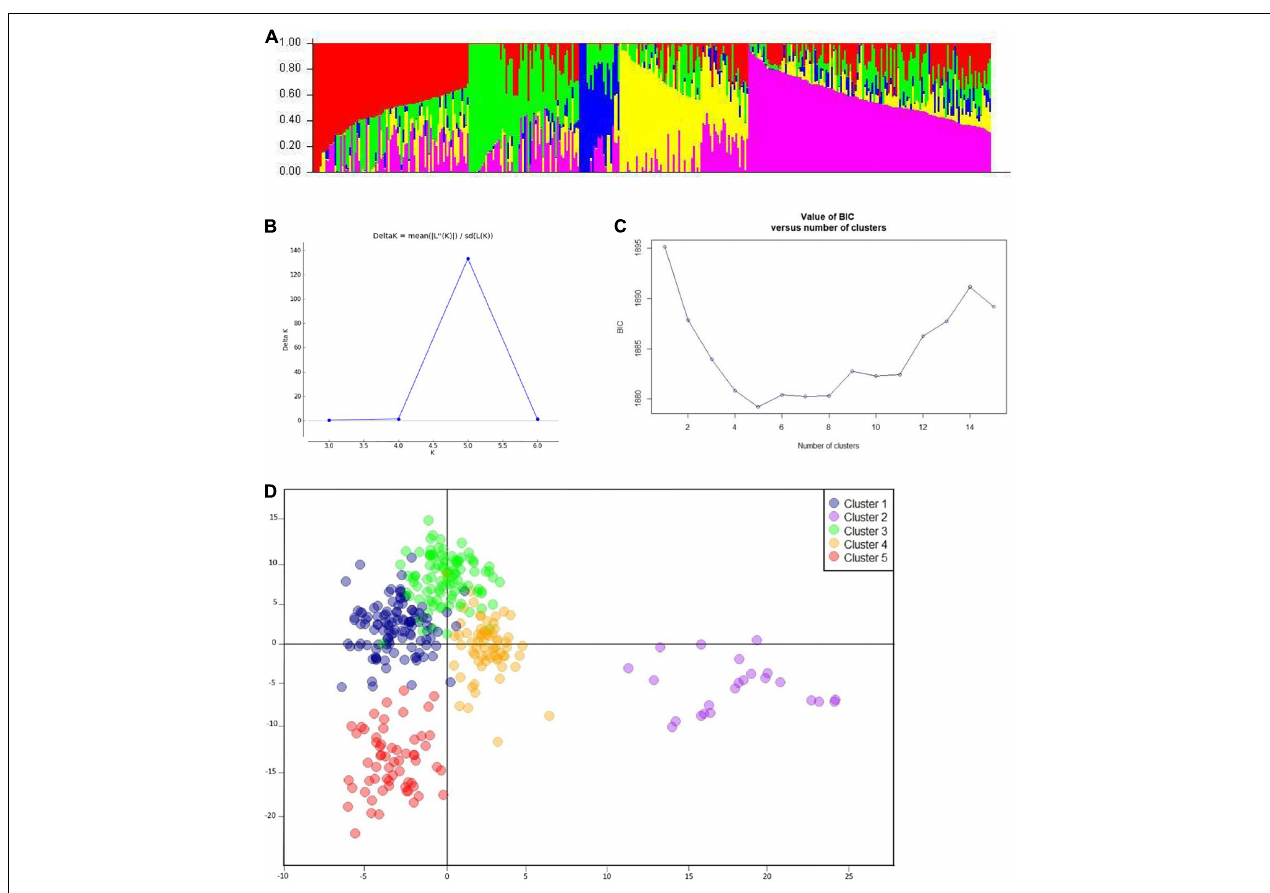
FIGURE 3 | Analysis of population structure. (A) Estimated population structure ( K = 5) of SAMP (369 ABLs), where each color represents a single sub-population. (B) Delta-k values as described by Evanno et al. (2005). (C) BIC plot displaying number of subpopulations/clusters. (D) Discriminant analysis of principal components (DAPC) for 369 wheat ABLs in